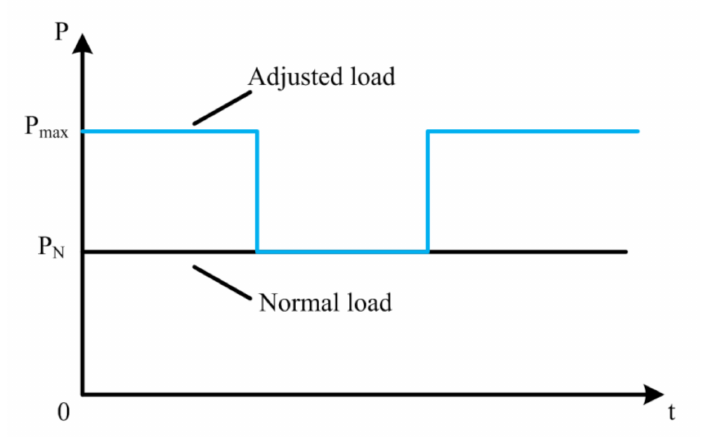
Figure 5. Schematic diagram of electrolytic aluminum load regulation